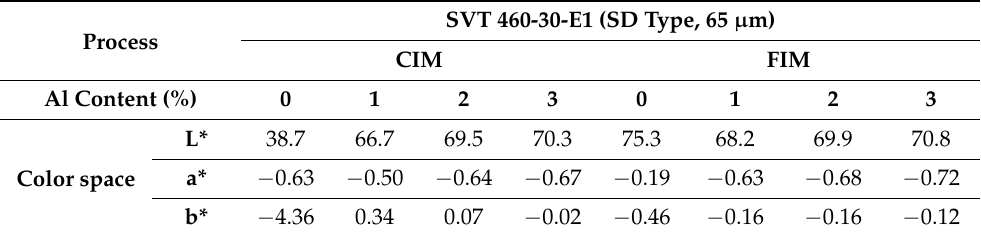
Table 5. Comparison of color spaces for products produced by conventional and foam injection methods.